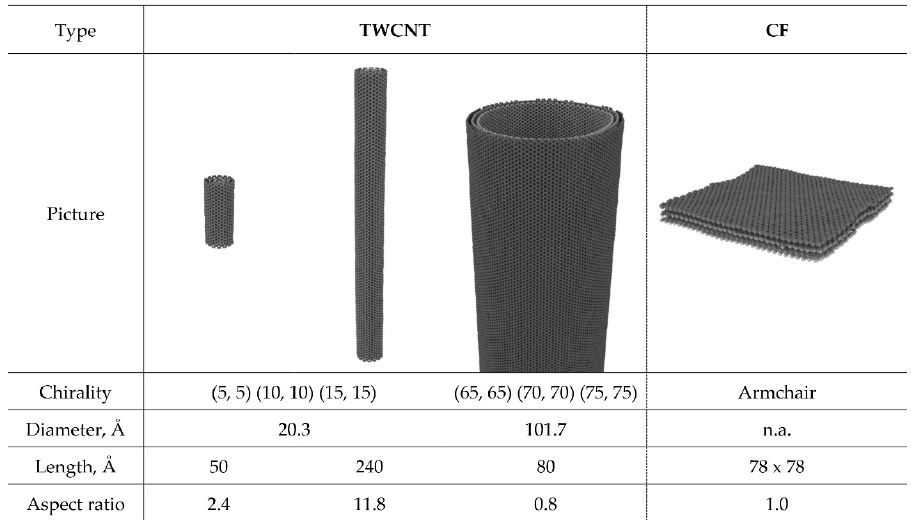
Figure 2. Structure and characteristics of modeled carbon reinforcements (triple walled carbon nanotubes (TWCNT) and carbon fibers (CF)).